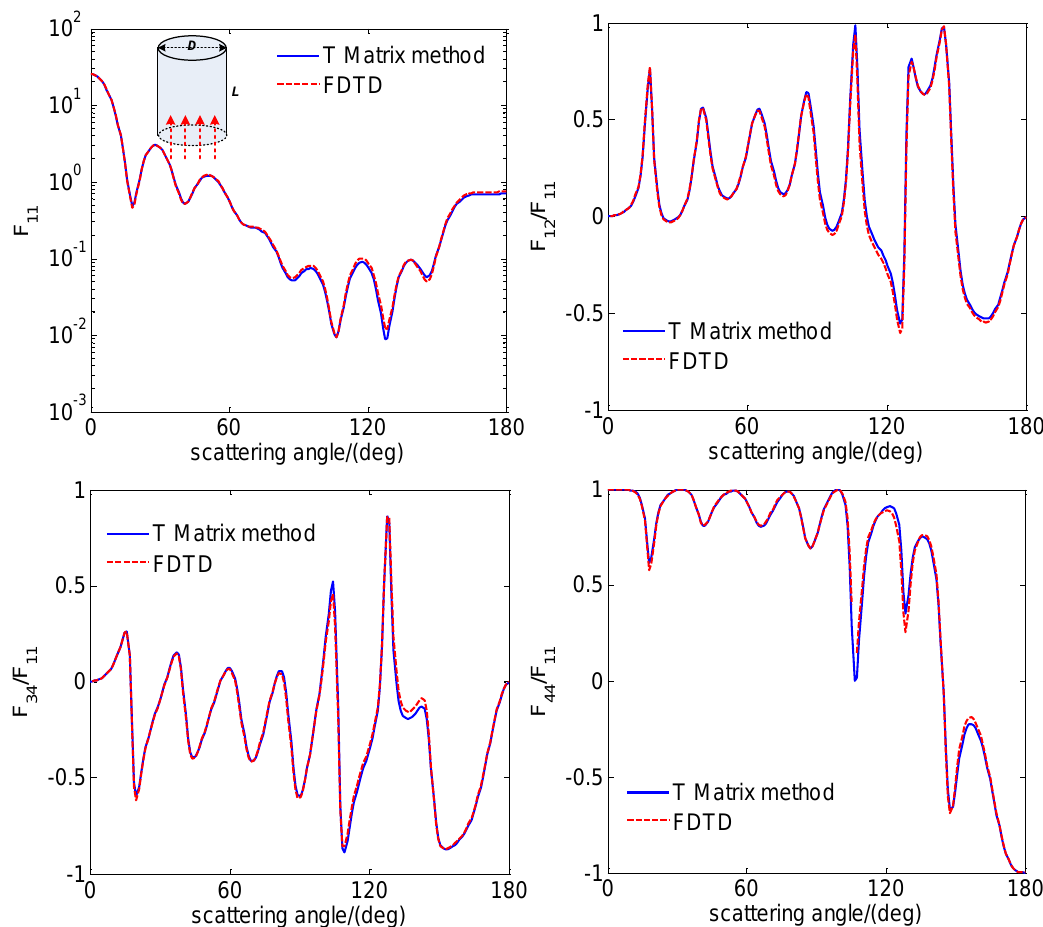
Figure 4. Comparison of the Müeller Matrix simulated by T Matrix method and parallel FDTD model for cylindrical particle. The validation of integral scattering properties . In this comparison, the incident light wavelength is taken as 0.8um, the particle is set as a sphere with its size parameter X changes from 1 to 50, and the complex refractive index is set to be 1.33-0.005i. The integrated scattering parameters (extinction efficiency Q ex , absorption efficiency Q ab and single scattering albedo SSA) are simulated by FDTD and Mie scattering theory, the results are shown in Figure 5.